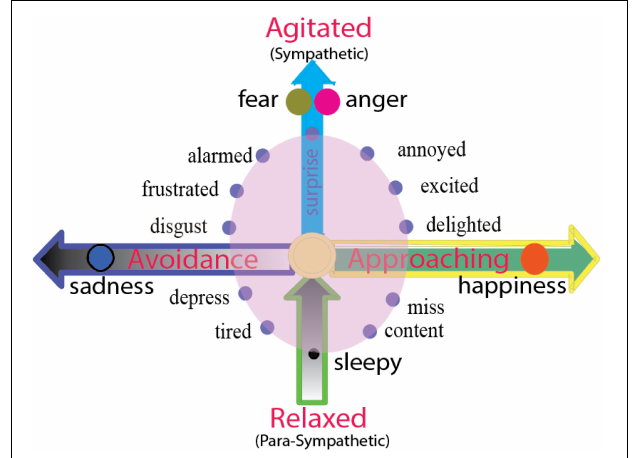
FIGURE 3 | Two dimensions of emotion reflect the directions of behaviors or agitation of autonomous nervous system. The horizontal dimension represents the direction of the behavior, including the approaching/avoidance of the behavior. The emotion happiness and sadness and their behaviors prey or fleeing are on the opposite directions, happiness or joy induce approaching behavior, and sadness and disgust induce avoidance behavior. The vertical dimension represents the energy of the action (agitated or rest). Fear and anger or fight or flight might have same level of agitation, but they are twin emotions, standing back-to-back on the top of vertical axis, facing opposite direction (approaching or avoidance). The zero point of the vertical dimension means normal waking state, and negative axis means sleepy or tired, or the vertical dimensions above zero means sympathetic nervous system, and the dimensions below zero means para-sympathetic nervous